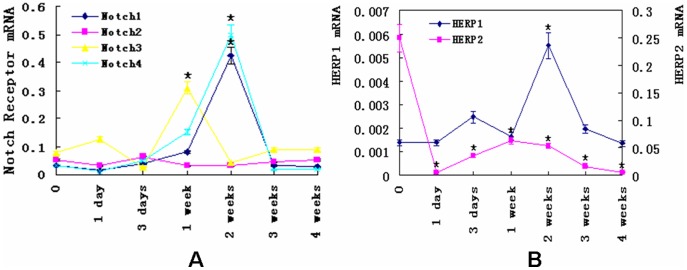
The gene expression of Notch receptors and their downstream effectors in PH rats.(A) the change of mRNA levels of Notch1-4 receptors in lung tissues of hypoxia rats. Notch3 mRNA level reached the peak at 1 week, whereas Notch1 and Notch4 did at 2 weeks. Compared to the baseline, the increase of Notch3 mRNA level was two folds, Notch1 four folds, and Notch4 five folds. All of them returned to the baseline by 3 weeks. (B) the change of mRNA levels of HERP1 and HERP2 in lung tissues of hypoxia rats. The mRNA level of HERP1 reached the peak at the second week and returned to basa level at the following days. The mRNA level of HERP2 decreased at the first day and maintained a low level in the following days. (*, P<0.05 compared to control group, Data were normalized to GAPDH and expressed as means ± s.e.m.)